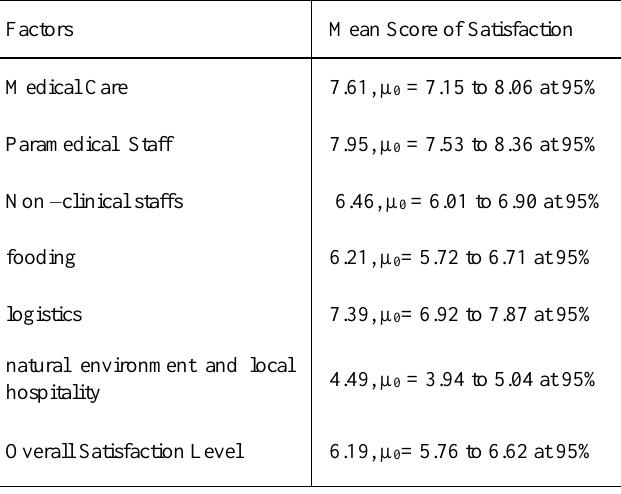
Table 5 (b) Level of satisfaction among domestic patient community